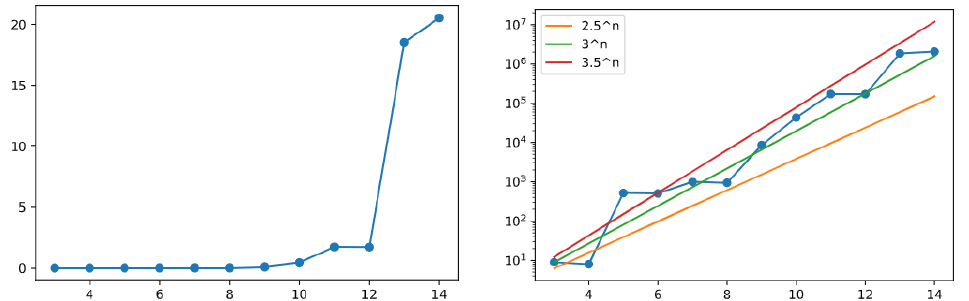
Figure 12. Amount of extra numbers proven to converge above row n when it has just been finished by the Golden Automaton in either linear or log scales [42].